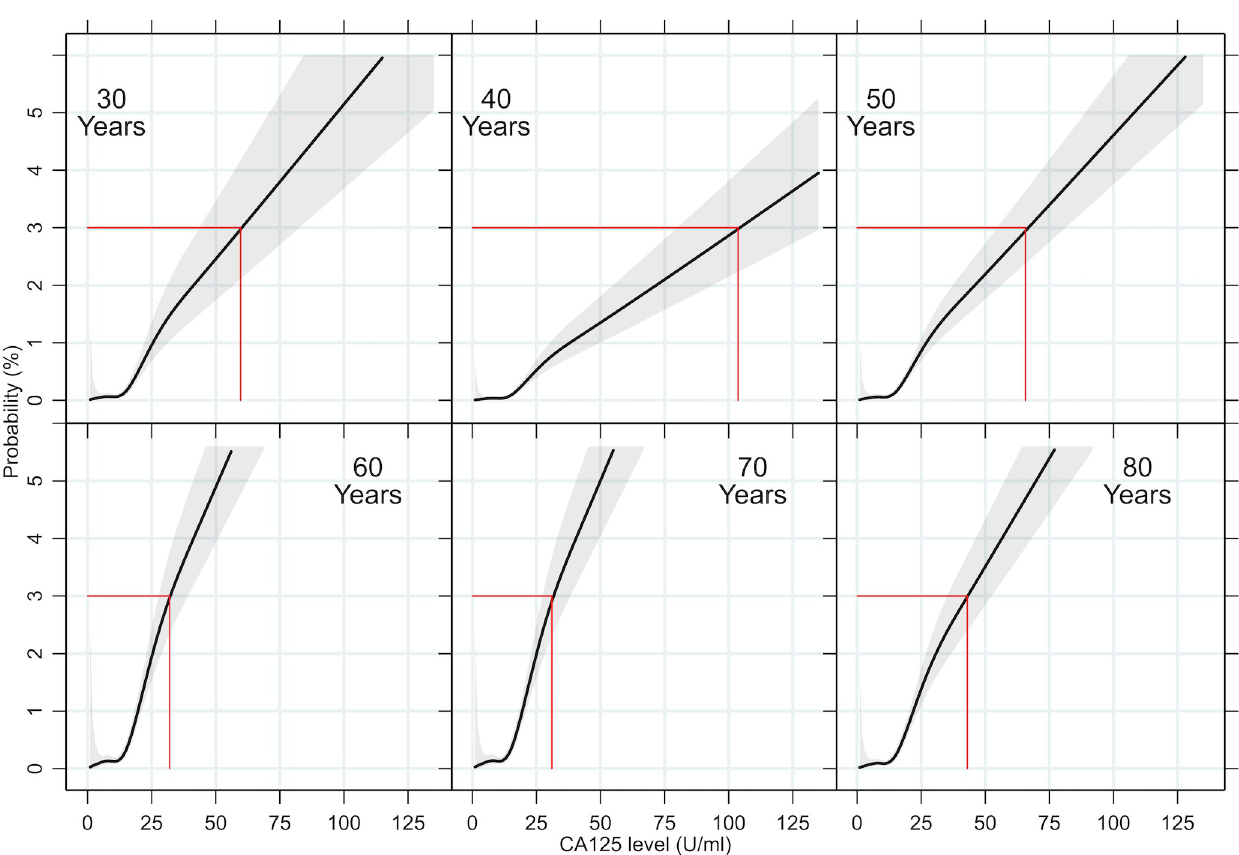
Fig 3. Relationship between CA125 level and estimated probability of ovarian cancer for women of different ages. Estimated ovarian cancer probabilities are shown in relation to CA125 level for women of 30, 40, 50, 60, 70, and 80 years of age. CA125 levels that correspond to the closest integer probabilities of 3% are indicated in red. Confidence intervals (95%) are displayed. Data used to construct these graphs (up to a CA125 level of 1,000 U/ml) are available via the University of Cambridge Repository [27]. CA125, cancer antigen 125.